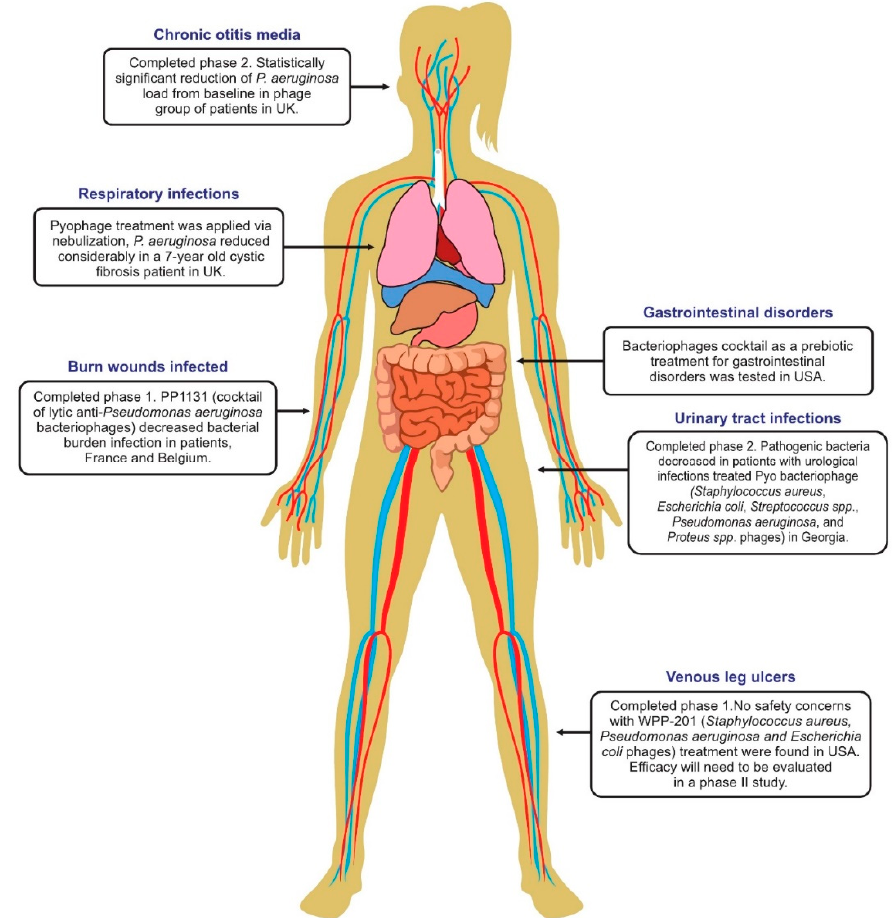
Figure 1. Human phage therapy trials and the range of target sites/infections. Image adapted from Furfaro et al. [46].